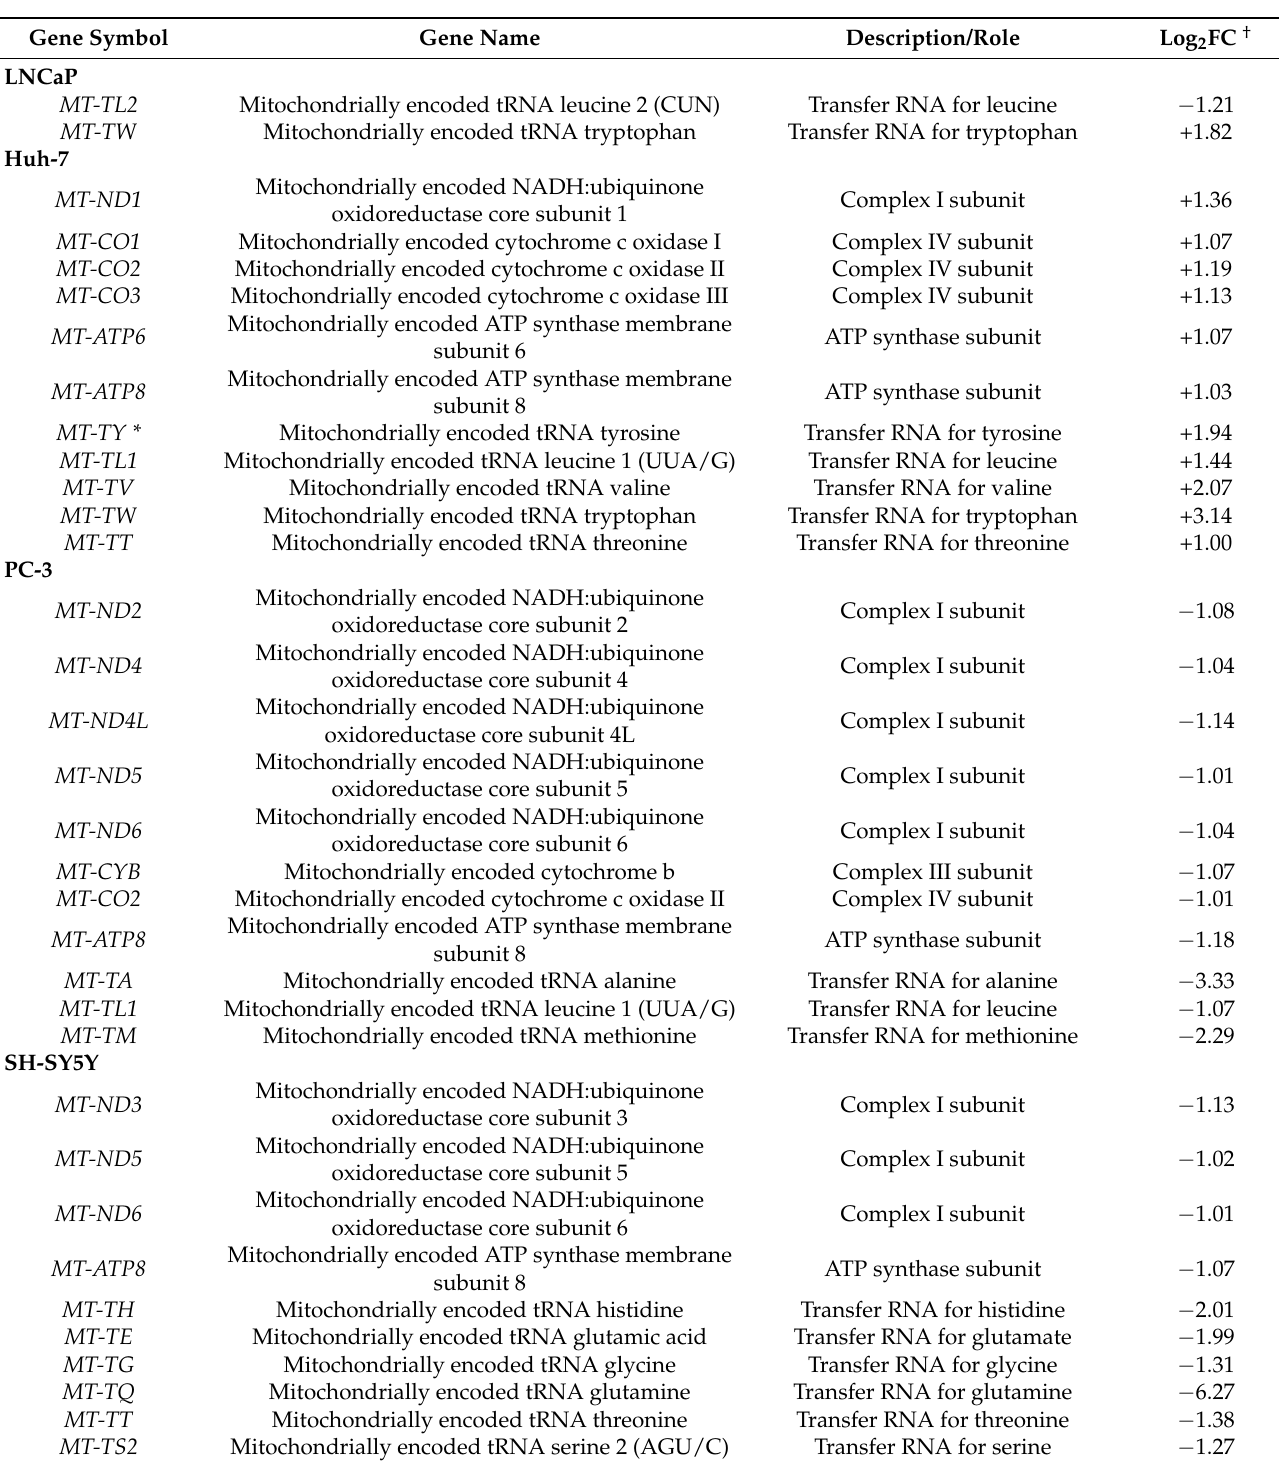
Table 2. Mitochondrially-encoded genes differentially expressed at 18% versus 5% O 2